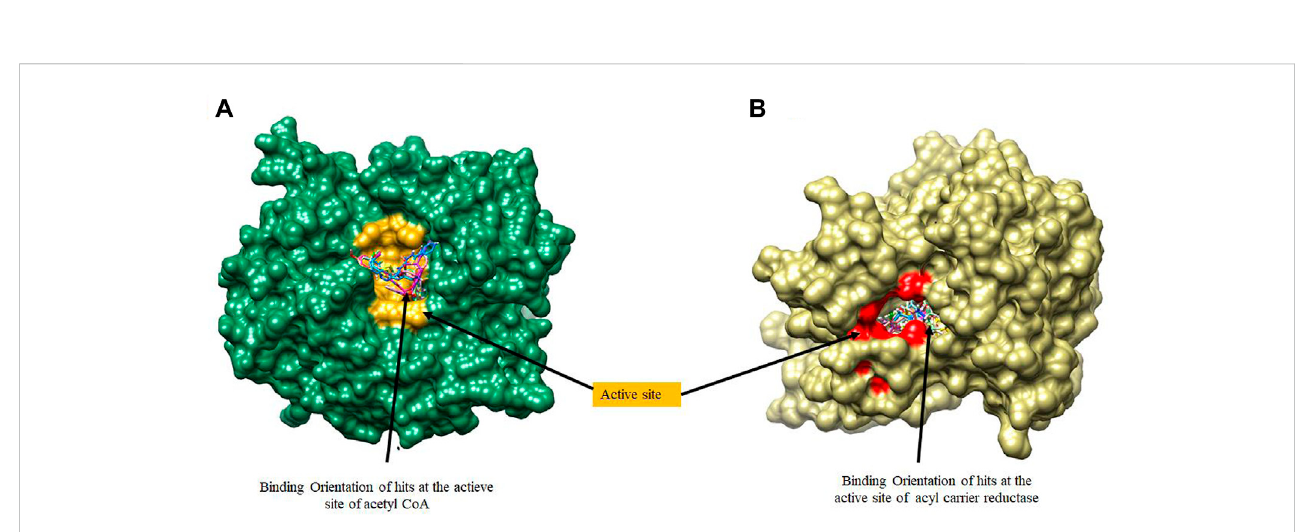
Table 2; Table 3 all hits across both targets have molecular weights below 500 Da threshold. A low molecular weight